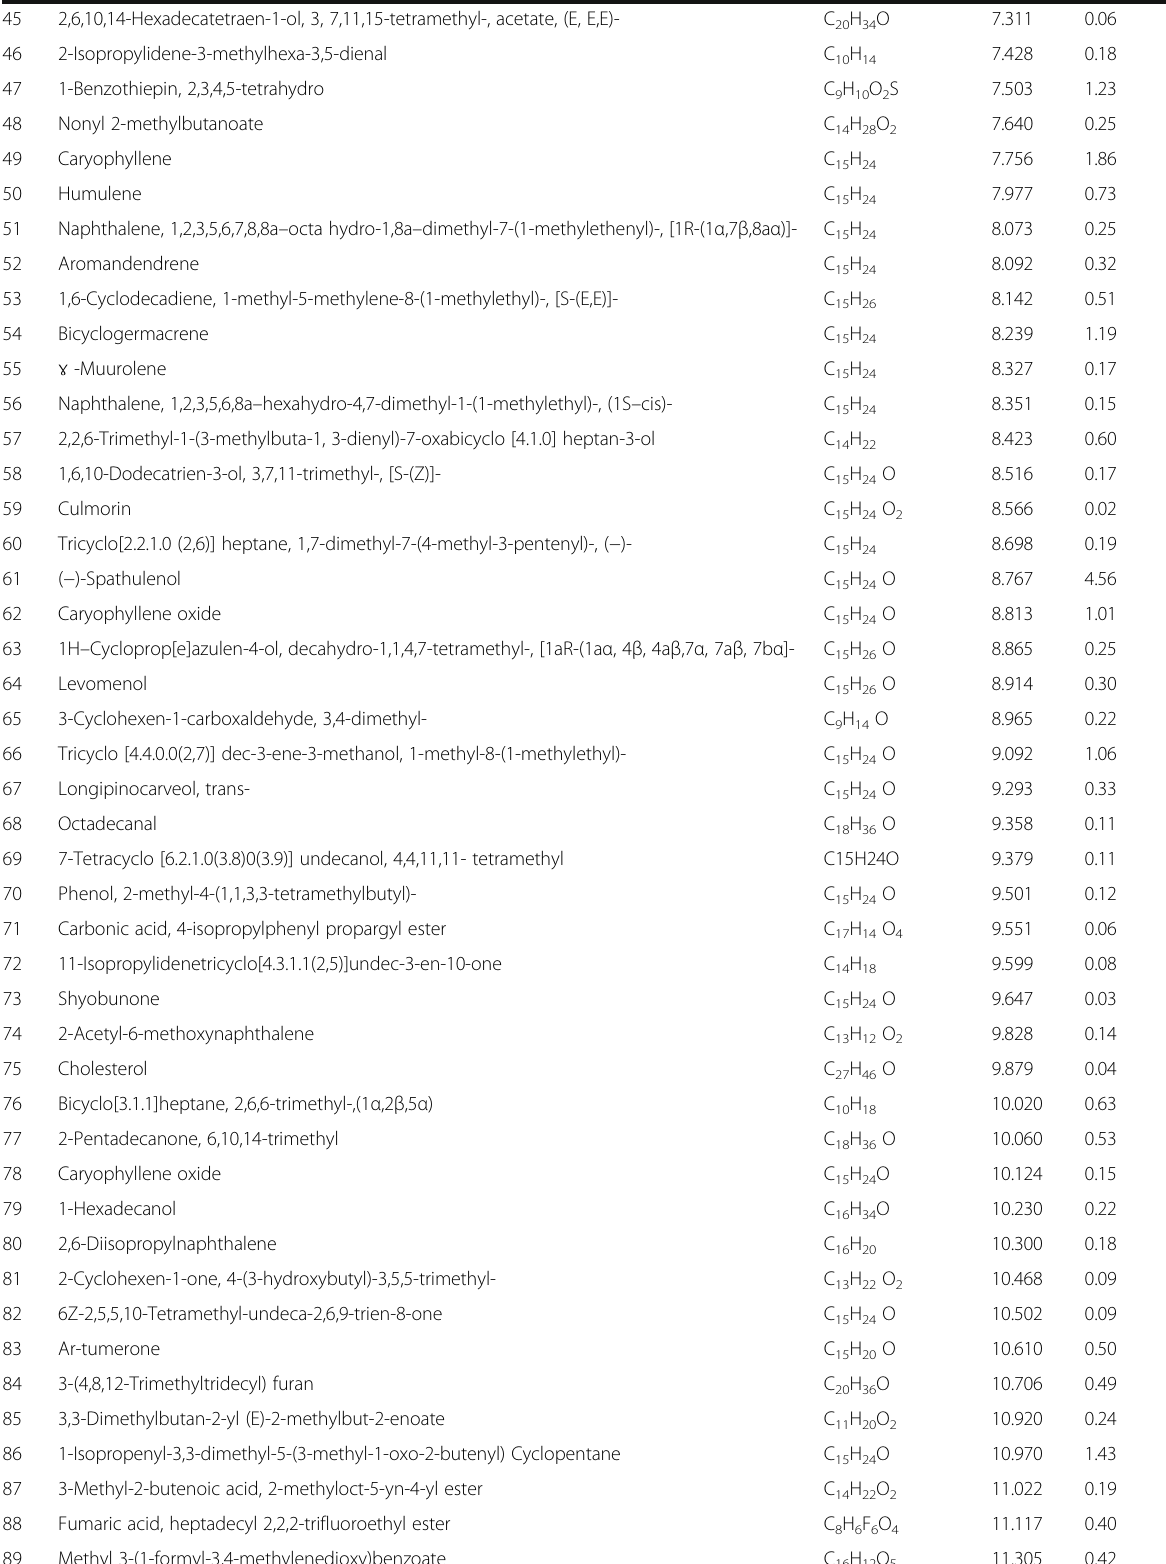
Table 2 Chemical composition of the essential oils of T. minuta flower